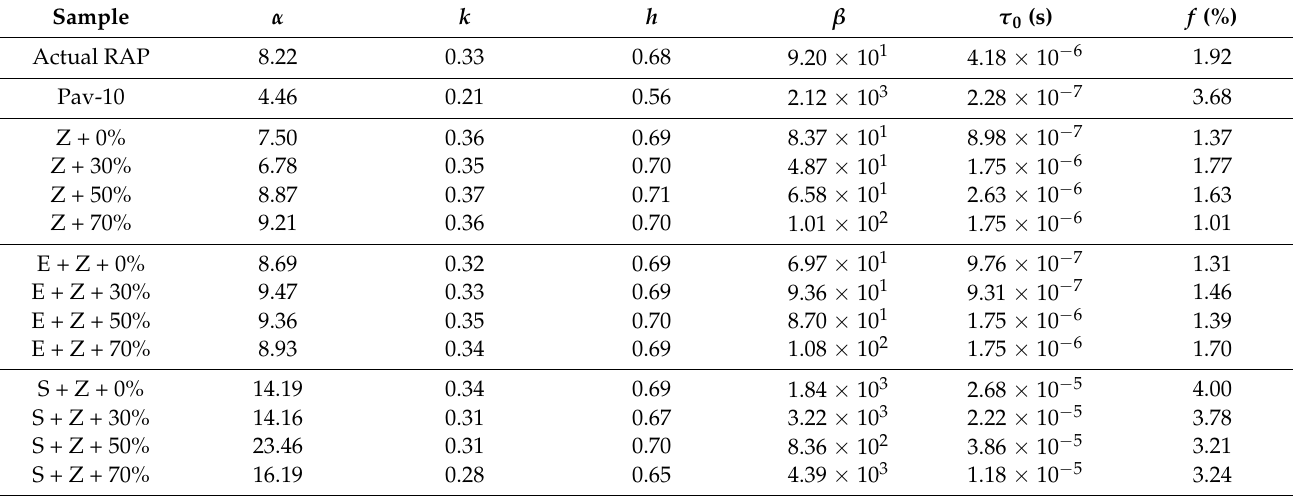
Table 14. Resulting parameters of the 2S2P1D model and fitting errors for the